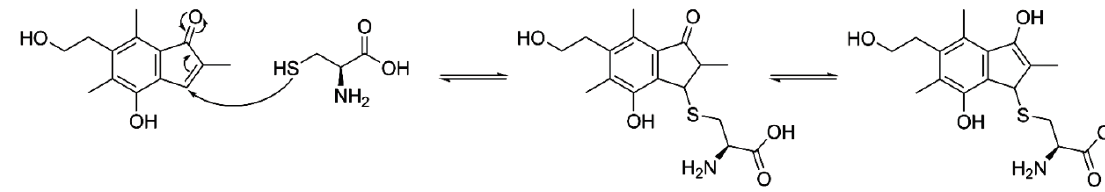
Figure 4. Suggested mechanism of the reaction between L -cysteine and compound 3